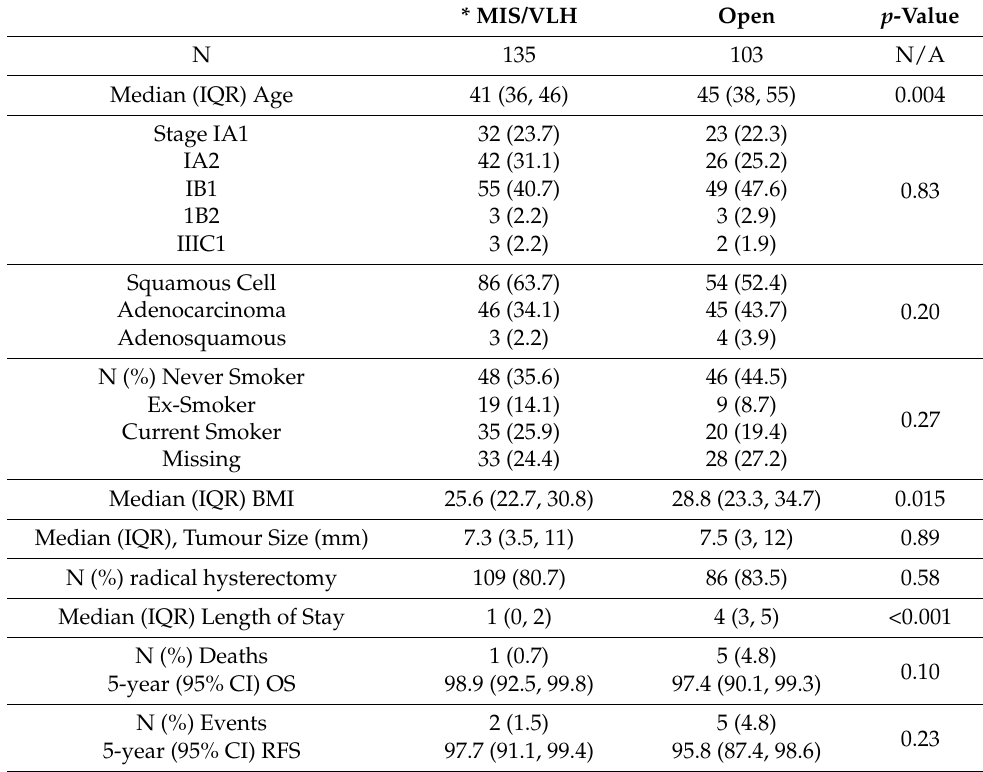
Table 2. Characteristics of patients grouped by surgical approach.